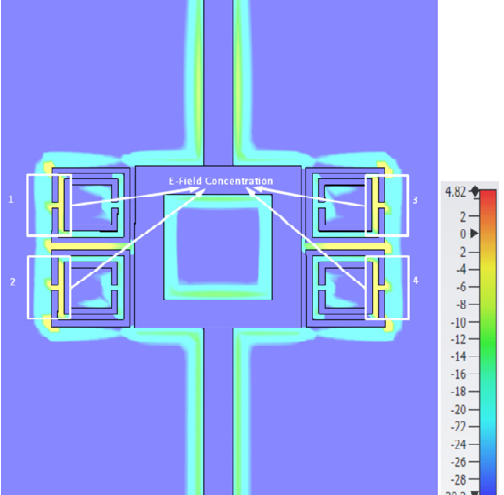
Figure 13. Simulation of E-field concentration at fr = 5.122 GHz (The highlighted region 1-4 shows a yellow color, indicating regions of high electric field concentration that are sensitive to the small changes in MUT).